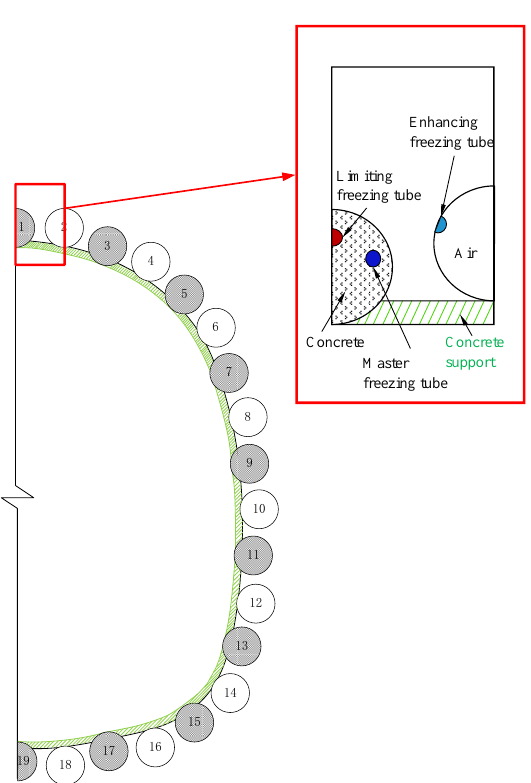
Figure 2. Local view of FSPR structure.